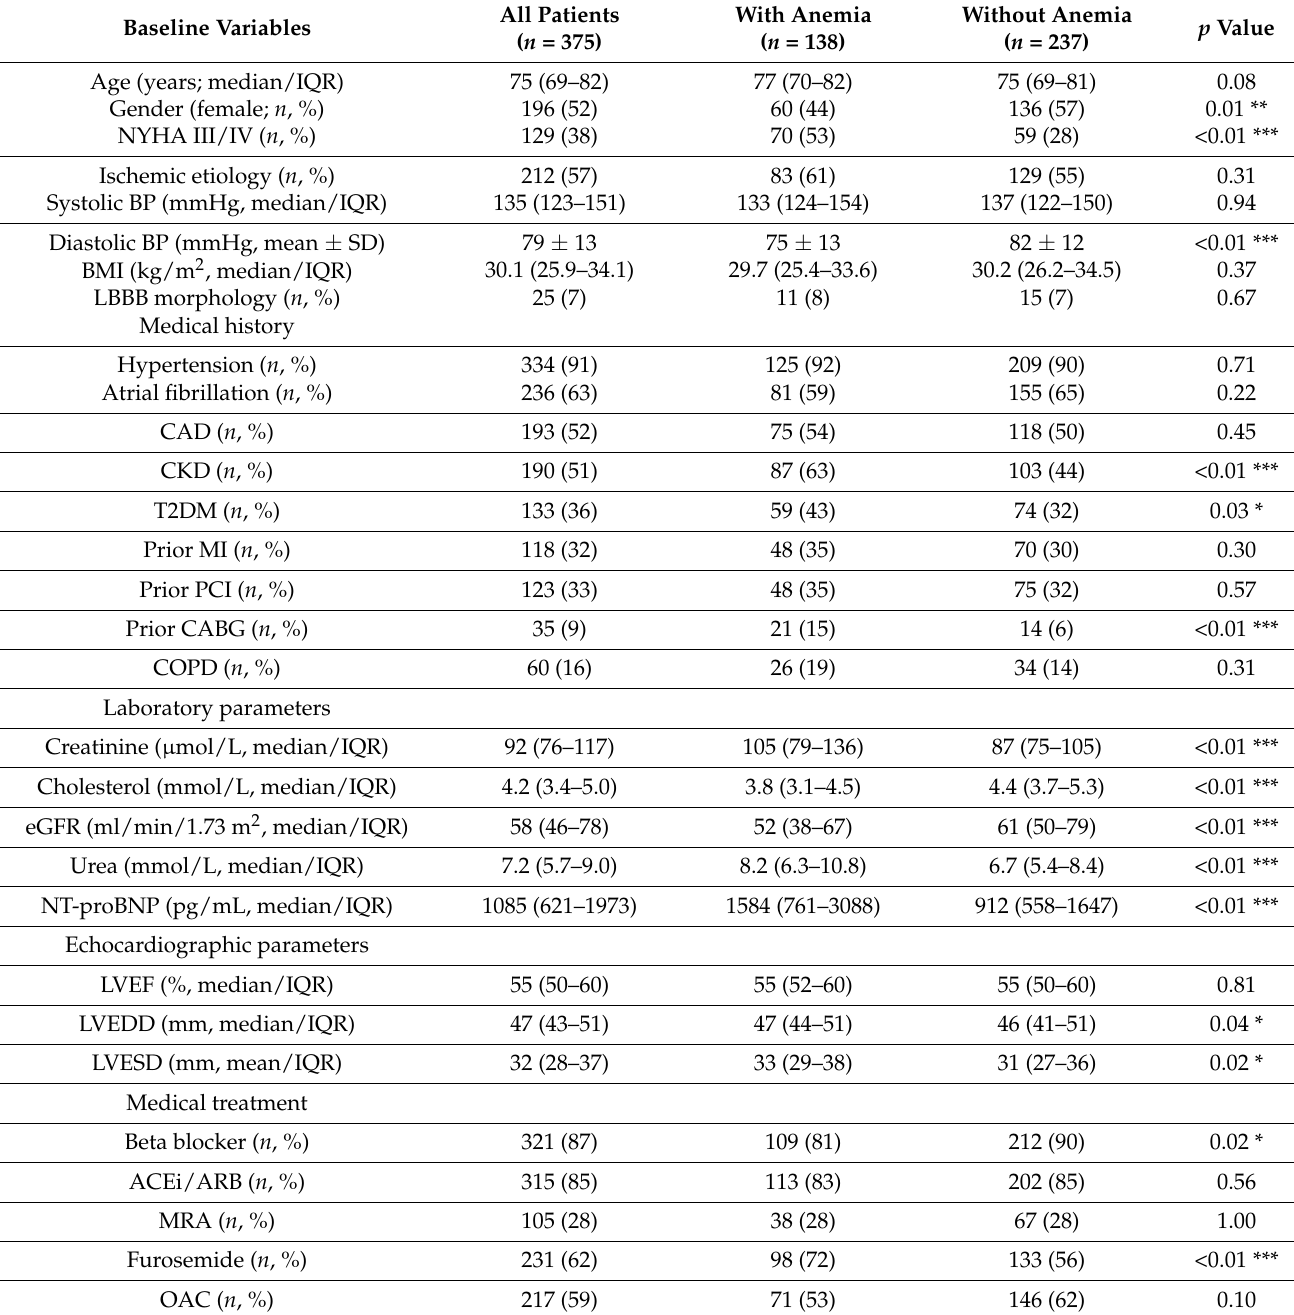
Table 2. Baseline clinical characteristics of patients without